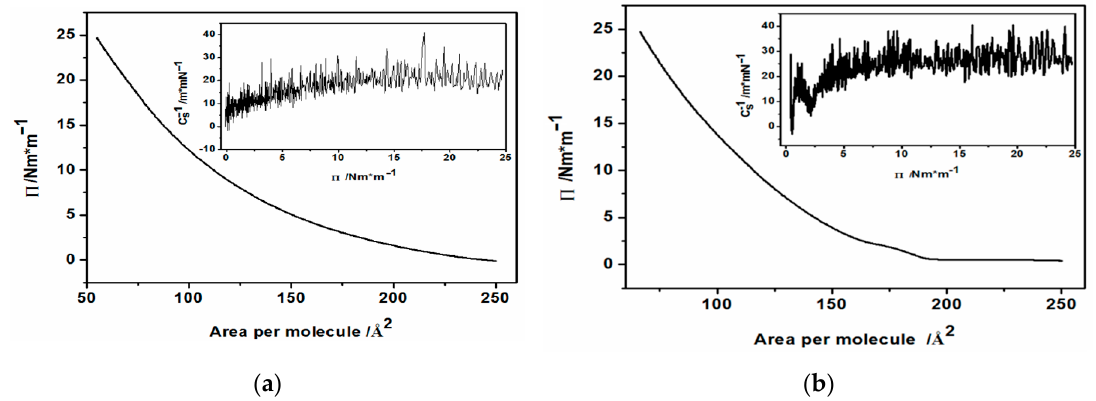
Figure 1. The isotherms of ( a ) oleylamine and ( b ) CdS nanoparticles capped with oleylamine. The insets show compressibility moduli vs. Π for pristine oleylamine and CdS.